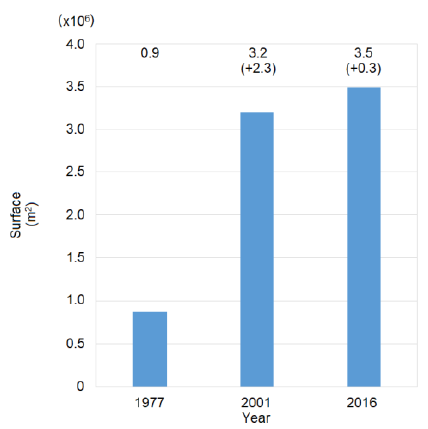
Figure 6. Evolution of the surfaces occupied by anthropic interventions during the studied periods. The number on top of histograms represents the total value of surface occupied, and in brackets shows the increment recorded among successive periods.